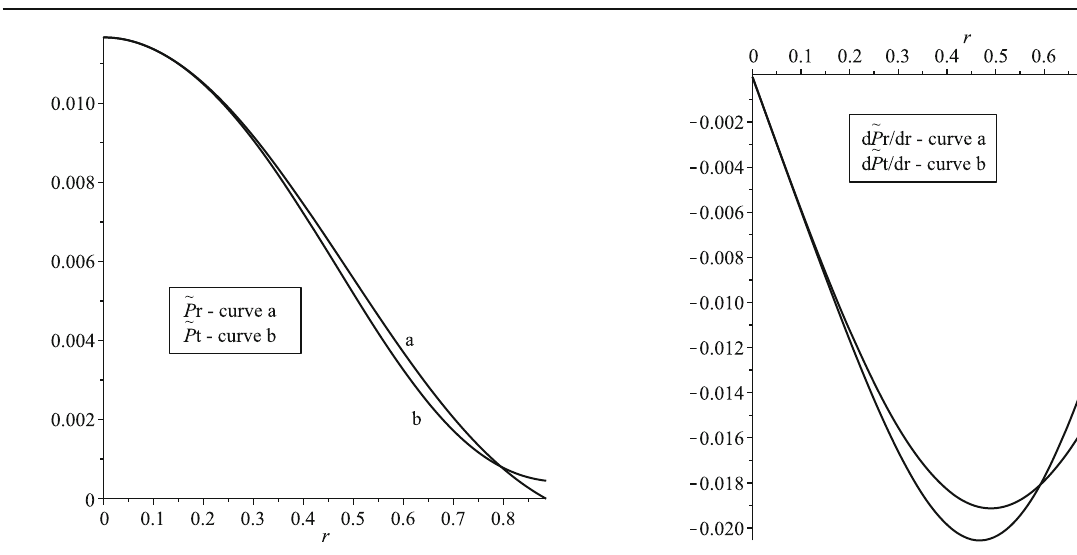
Fig. 3 Gradients of the pressures for the solution obtained with the first algorithm with F = 0 from the isotropic Gold III solution